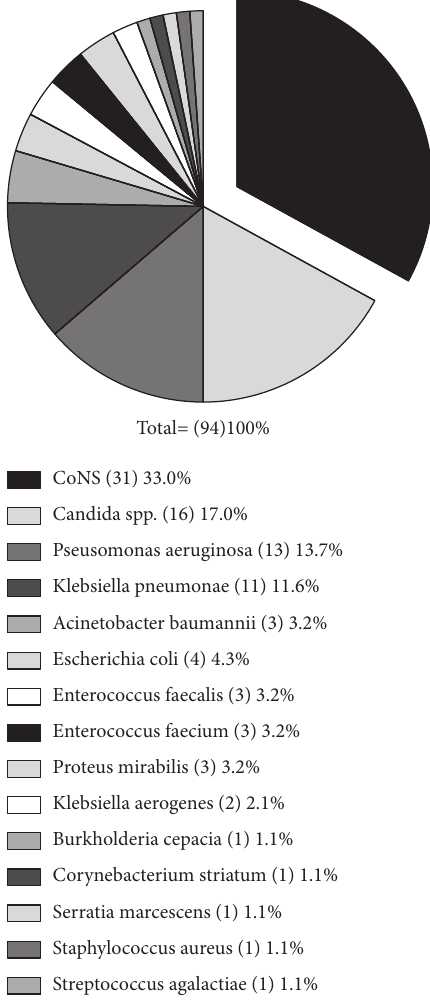
Figure 1: Prevalence of bacterial and yeast strains isolated from medical Table 2: Main bacterial and yeast isolates from different medical devices.